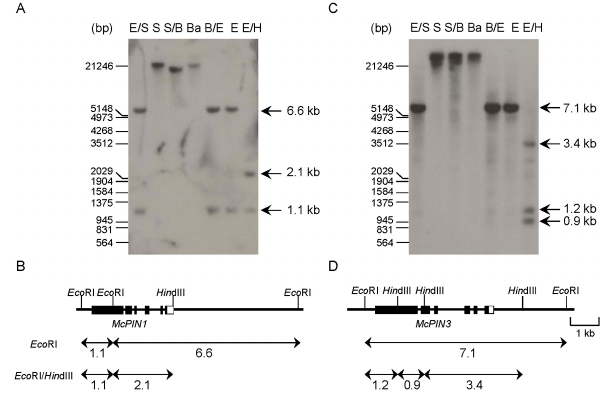
Figure 3. Southern blot analysis using auxin efflux carrier cDNAs from bitter gourd as probe. Genomic DNA of bitter gourd was hybridized with 32 P-labeled insert of cDNA clone pMAEC43 for McPIN1 ( A , B ) and pMAEC93 for McPIN3 ( C , D ). Each lane contained 20 µg genomic DNA digested with Eco RI and Sal I (E/S), Sal I (S), Sal I and Bam HI (S/B), Bam HI (Ba), Bam HI and Eco RI (B/E), Eco RI (E), Eco RI and Hin dIII (E/H) and subjected to gel blot hybridization. Membrane was hybridized at 65 °C and washed at high stringency. Diagrams of the restriction maps and hybridization signals for McPIN1 ( B ) and McPIN3 ( D ) are presented according to the restriction patterns of cDNAs and Southern blot analyses. The locations of both cDNAs are shown by black rectangular boxes. Hybridized signals are indicated by arrows with double heads and numbers beneath arrows are sizes of the fragments.